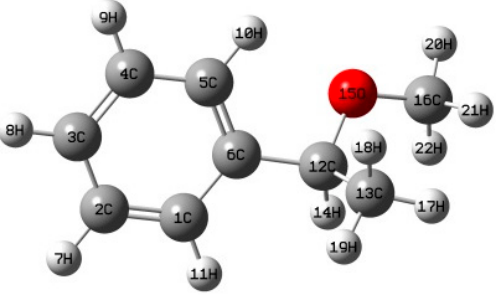
Figure 3. Parr index for the oxygen atom at Int1.